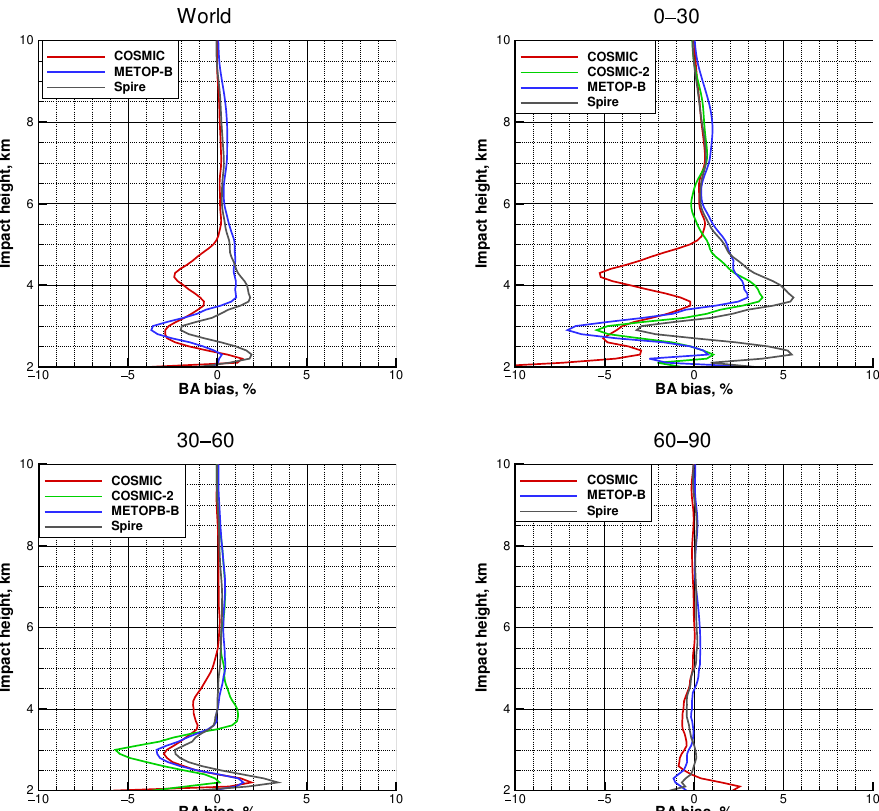
Figure 17. Statistical comparison of bending angles retrieved from RO observations with GFS analyses for different missions and for each mission’s median normalized SNR from Table 1. Systematic difference, dynamic normalization. Upper left: world, upper right: tropics, lower left: middle latitudes, lower right: polar latitudes. All the latitude bins cover both North and South